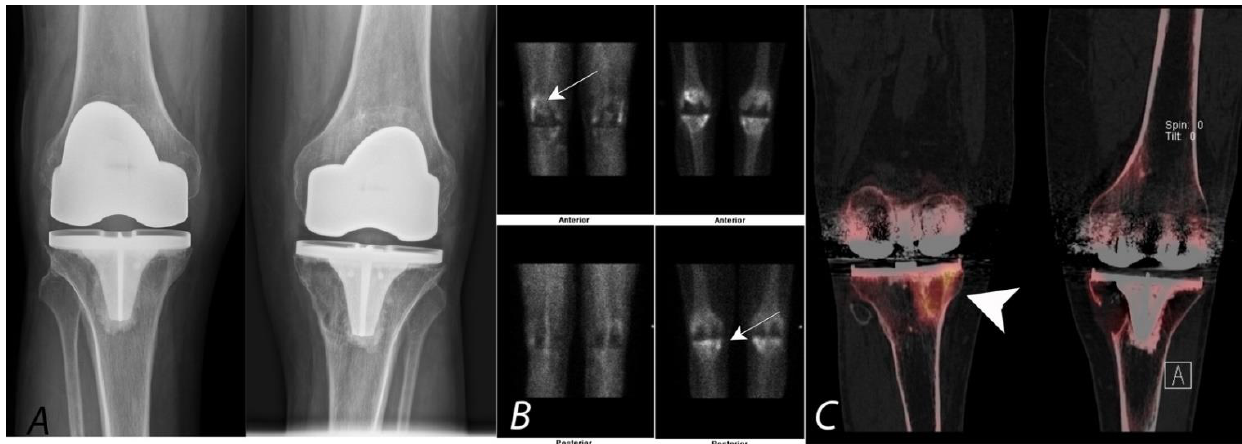
Figure 8. Bilateral anterior AP radiographs, anterior and posterior planar blood pool and delayed mineral phase images and coronal SPECT/CT images of a Tc-99m MDP bone scan in a 65-year-old male with bilateral painful total knee protheses. Plain radiographs ( A ) are non-specific (and unchanged over several years) without defined peri-prosthetic lucency. Blood pool images and delayed images ( B , C ) demonstrate some hyperemia in the joint capsule and serpiginous areas of proximal tibial uptake (white arrows). Clarity is achieved by the SPECT/CT (coronal images, C ), which demonstrates uptake associated with large, well-corticated areas of bone loss consistent with particle disease (white arrowhead). A similar well corticated region of lucency is also present in the medial aspect of the left proximal tibia.